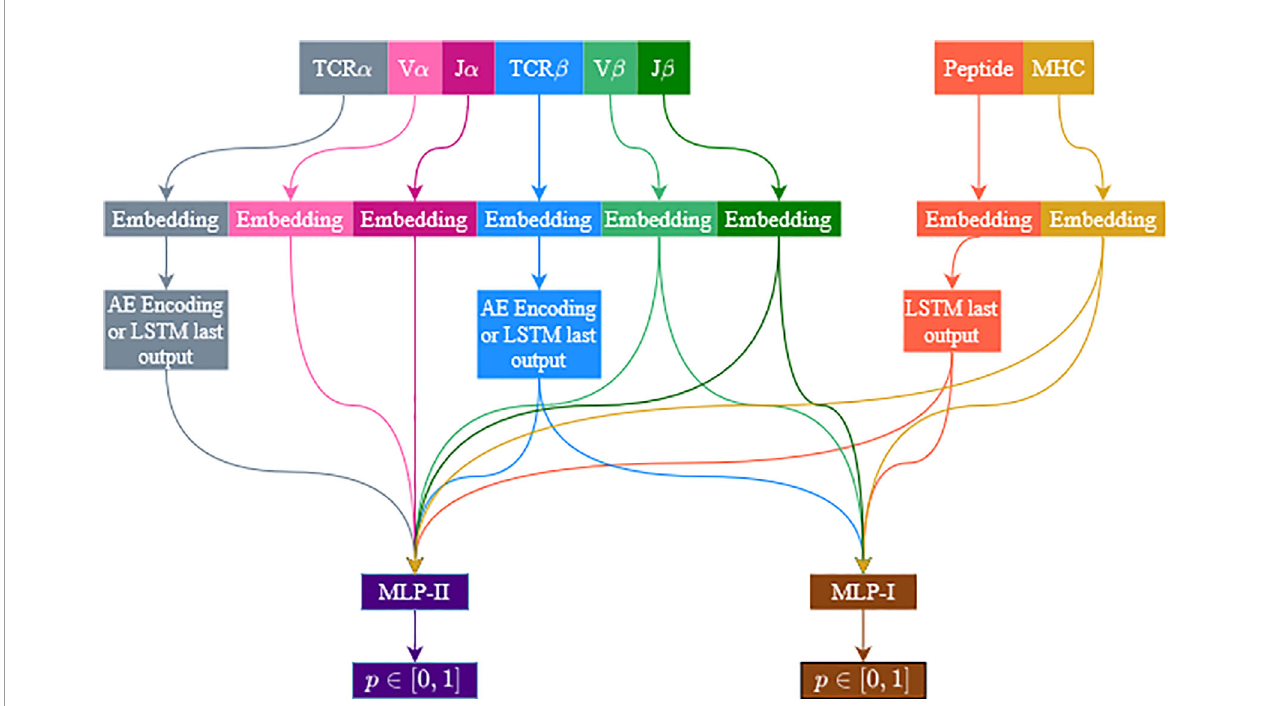
FIGURE 1 | Illustration of the model ’ s architecture. The architecture is fl exible and accommodates several feature con fi gurations. TCR b and peptide sequences are always used, while V and J genes and the TCR a sequence are optional. V a and J a are only used when TCR a is used. MHC usage is optional. TCRs are encoded with an autoencoder or an LSTM. Peptides are always encoded with an LSTM. Other features (except for the T-Cell type which is not illustrated) are encoded using a learned embedding matrix. Two MLP are used, one for samples including TCR a and the other for samples missing the TCR a sequence. We follow the current color code in the following fi